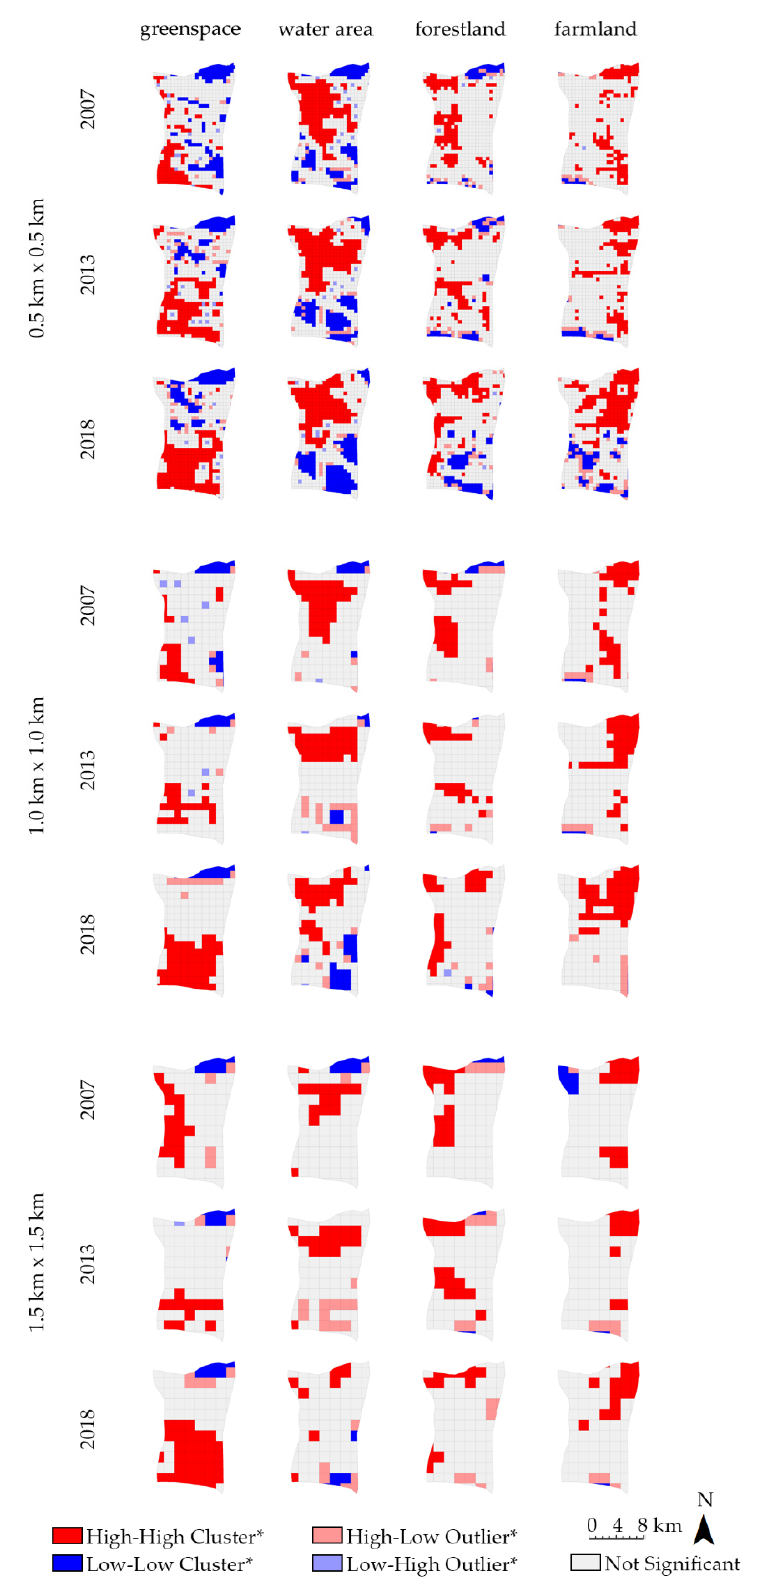
Figure 7. The LISA clustering map of COHESION for different GI. Note: * indicates 95% confidence interval ( p < 0.05).